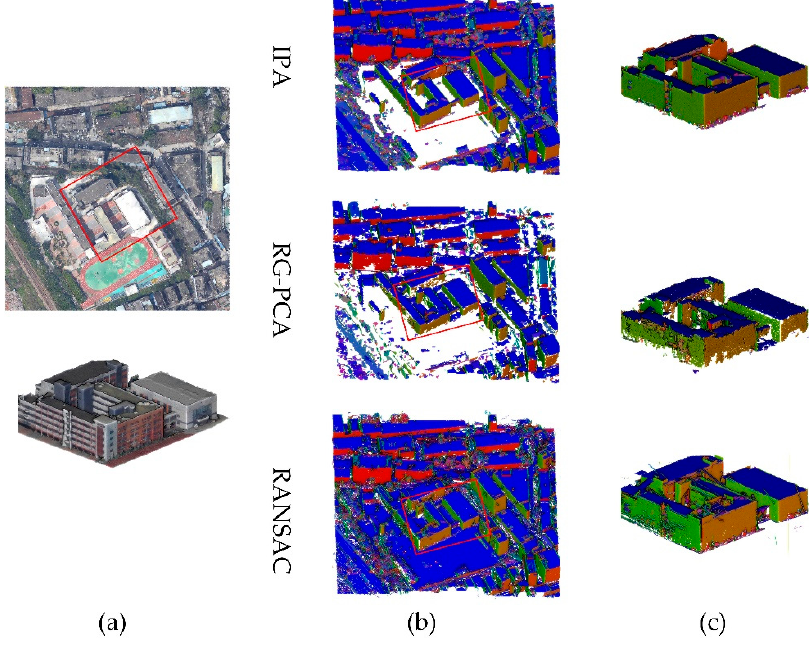
Figure 9. Comparison of planar surface extraction from the point cloud of tile 2.